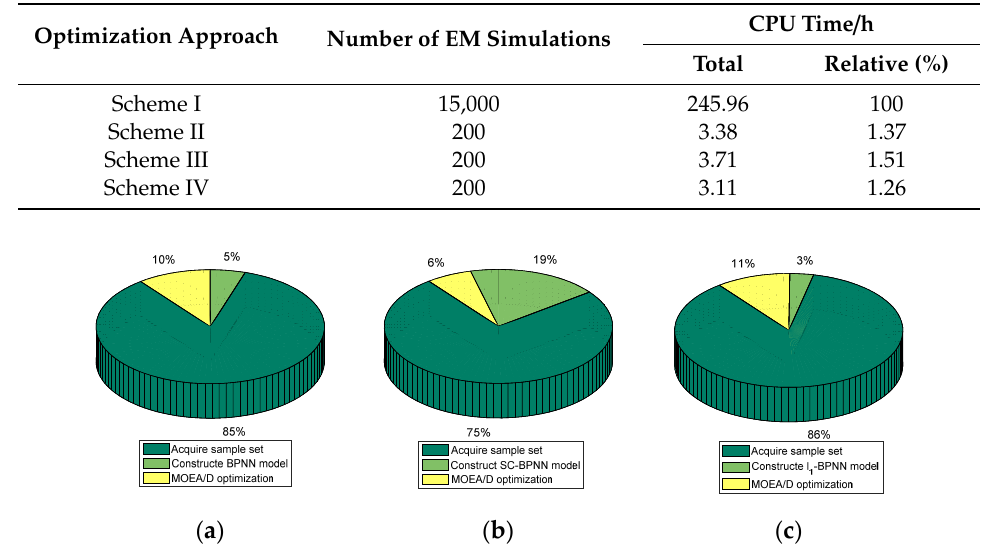
Figure 14. Time-consuming ratio of each part of the multi-objective optimization method using different surrogate models: ( a ) Scheme II, ( b ) Scheme III, and ( c ) Scheme IV.